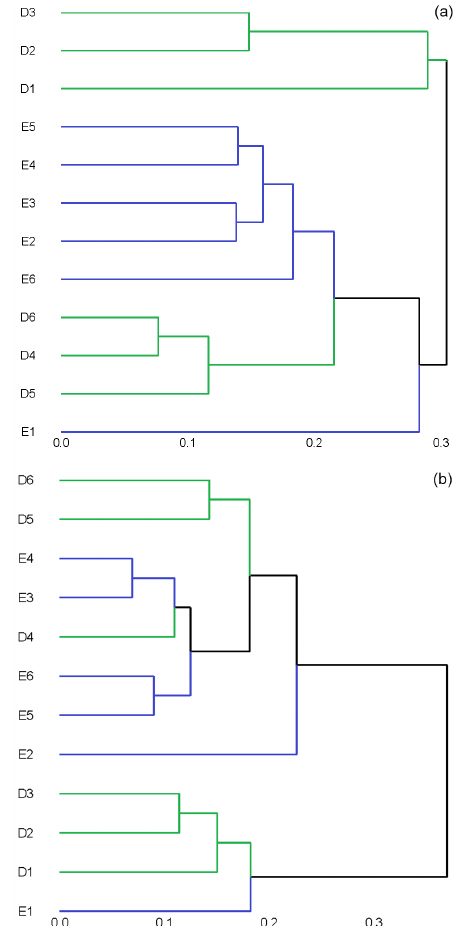
Figure 5. Environment clusters for archaeal 16S rRNA gene (a) and mcrA gene (b) assemblages based on UniFrac distance. The scale represents UniFrac distance. Samples D1–D6 and E1–E6 were retrieved from Dianchi Lake and Erhai Lake, respectively. Digits “1”–“6” refer to sediment depth 0–5, 5–8, 8–11, 11–14, 14–17, and 17–20cm,